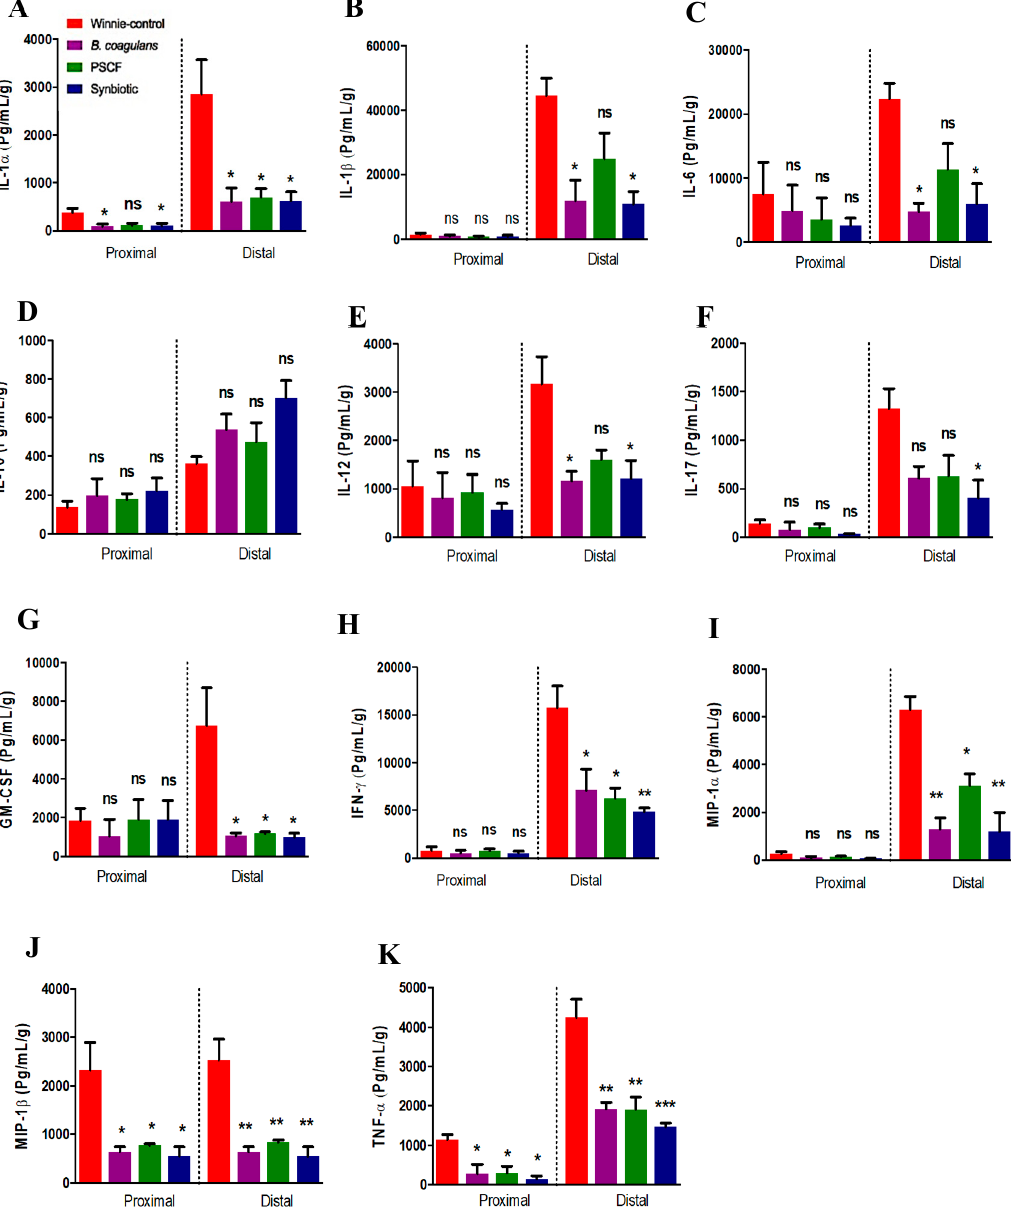
Figure 4. E ff ect of B. coagulans spores, PSCF and Synbiotic on immune markers in colon tissues. Protein levels of cytokines including ( A ) IL-1 α , ( B ) IL-1 β , ( C ) IL-6, ( D ) IL-10, ( E ) IL-12, ( F ) Il-17, ( G ) GM-CSF, ( H ) IFN- γ , ( I ) MIP-1 α , ( J ) MIP-1 β and ( K ) TNF- α in proximal and distal colon explants were analysed by Bio-plex. Statistical significance among groups evaluated by one-way ANOVA. * p < 0.05, ** p < 0.01, *** p < 0.001, ns-non-significant vs. Winnie-control and data expressed as mean ± SEM ( n = 3 per